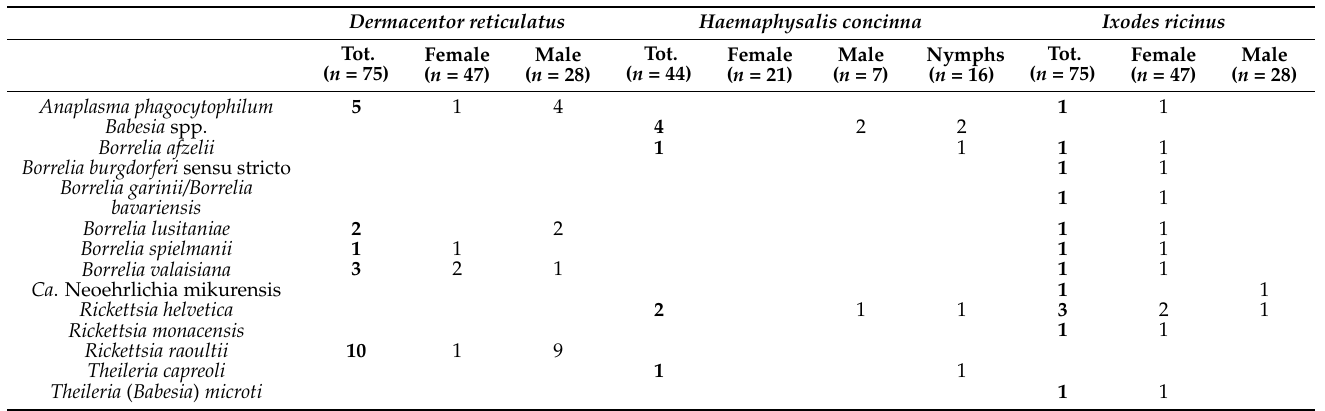
Table 2. Tick-borne microorganism DNA detected in ticks collected from dogs. Dermacentor